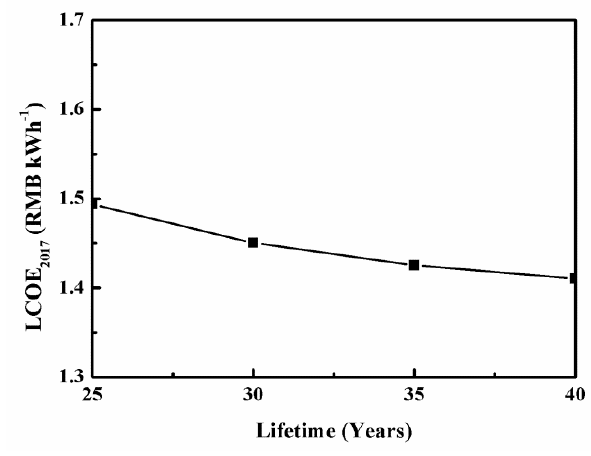
Figure 11. E ff ect of lifetime on the Figure 11. Effect of lifetime on the LCOE. Figure 11. Effect of lifetime on the LCOE.